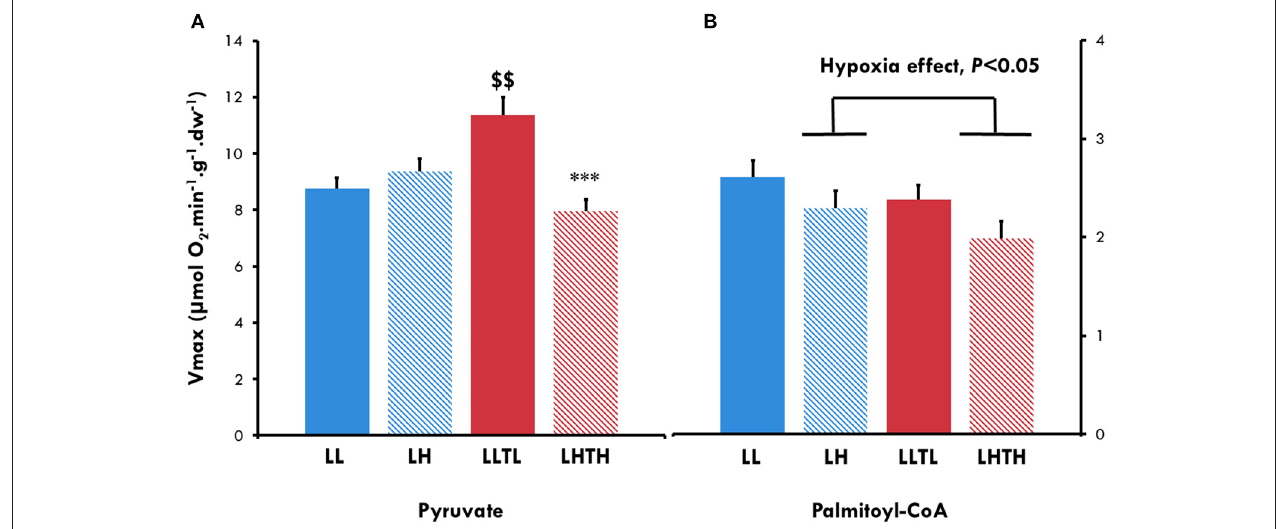
FIGURE 3 | Maximal oxidative capacity for pyruvate (A) and Palmitoyl-CoA (B) in plantaris skinner fibers of female rats at the end of conditioning. $$ Different from the sedentary group in the same environment, P < 0.01. ***Different from the normoxic group with the same level of activity, P < 0.001. Successive addition of 2mM